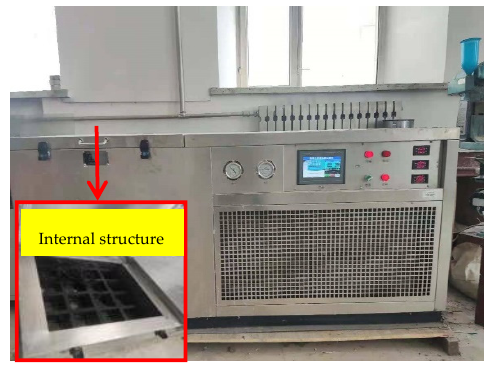
Figure 2. Freeze-thaw cycle machine.